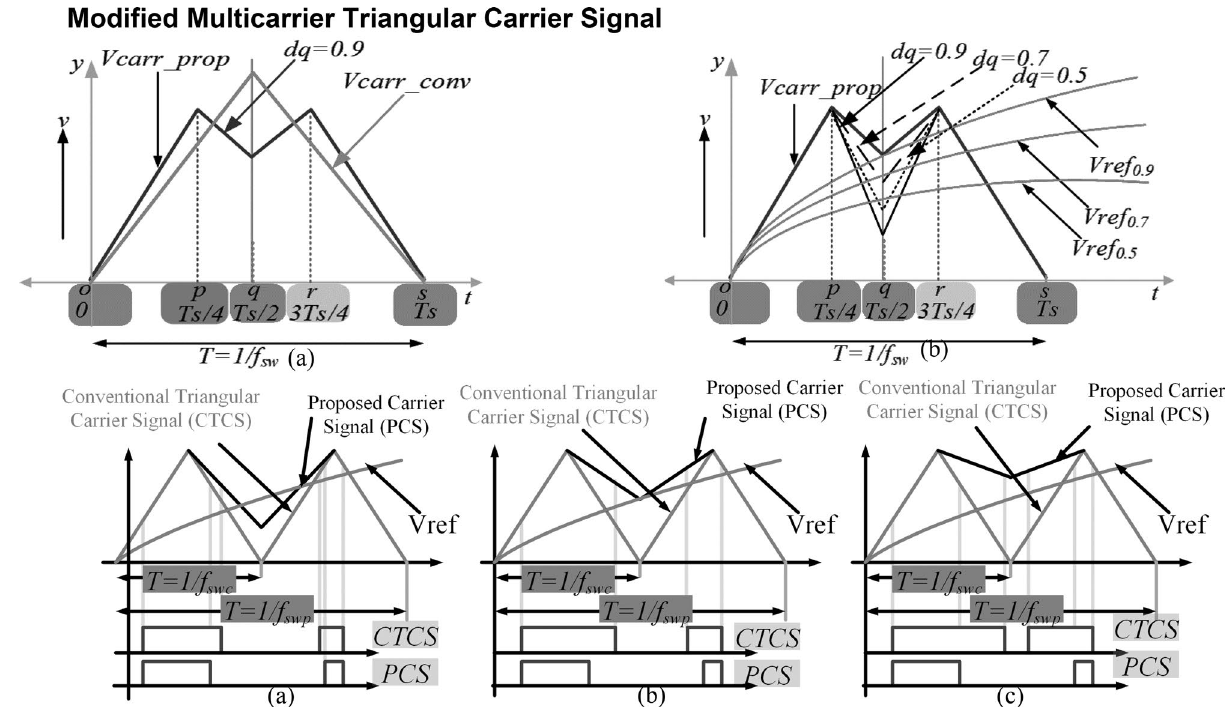
Figure 3. Proposed new carrier signal waveform ( a ) compared with conventional triangular waveform ( b ) with various dq points ( c ) comparison of proposed and triangular carrier signal with different pulse width